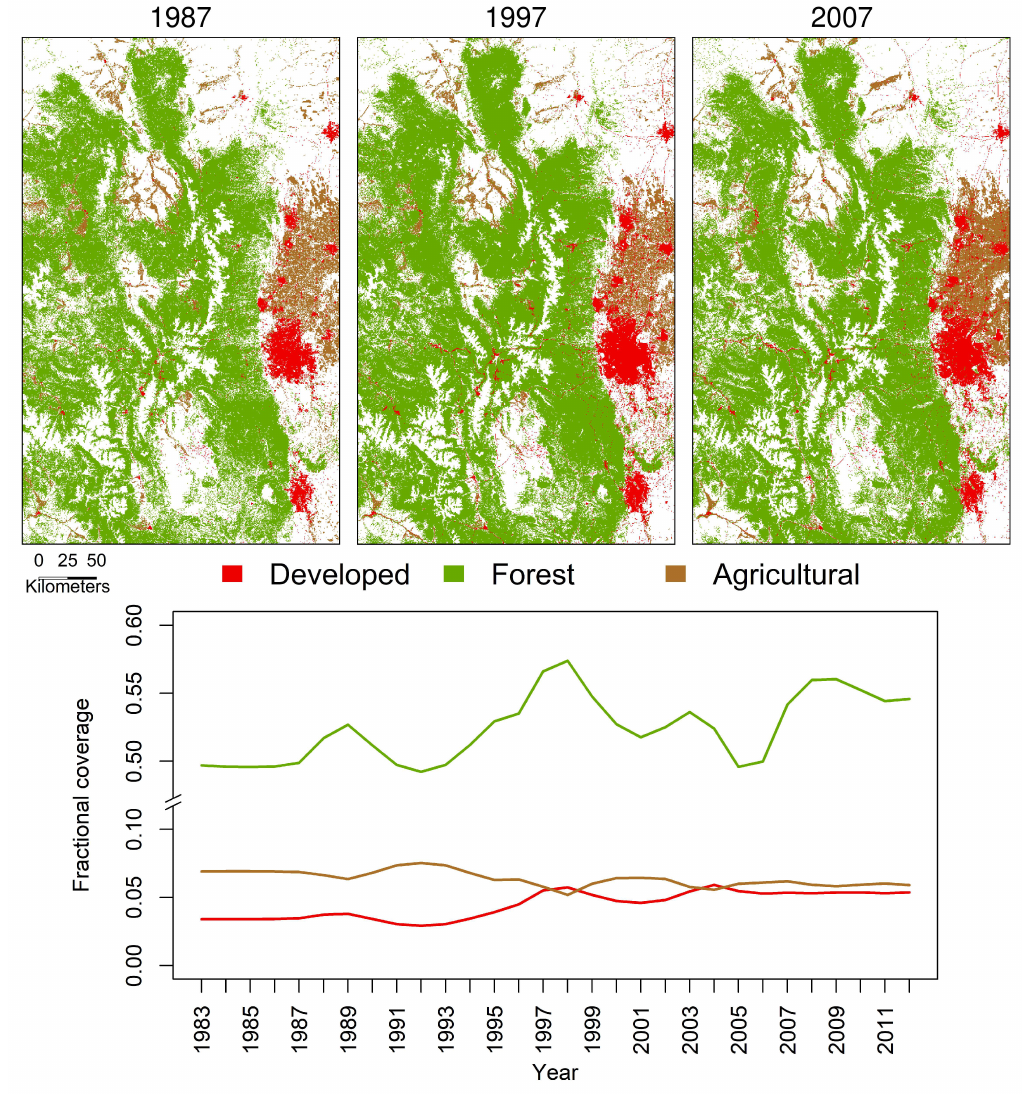
Figure A8. Land cover maps in the region of interest for the classes Developed, Forest, and Agricultural and the years 1987, 1997, and 2007 ( top ), and temporal evolution of the fraction of the stream network of interest covered by these three classes during the period 1983–2012 ( bottom